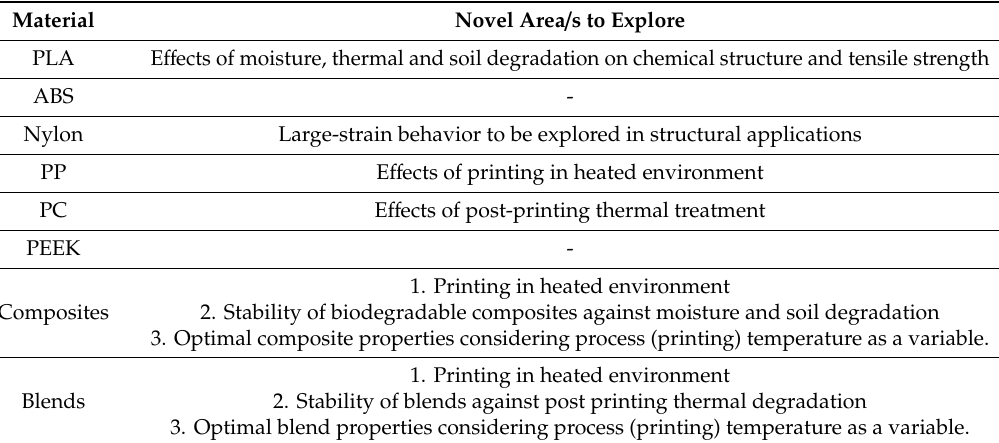
Table 7. Novel areas of research for di ff erent types of FFF